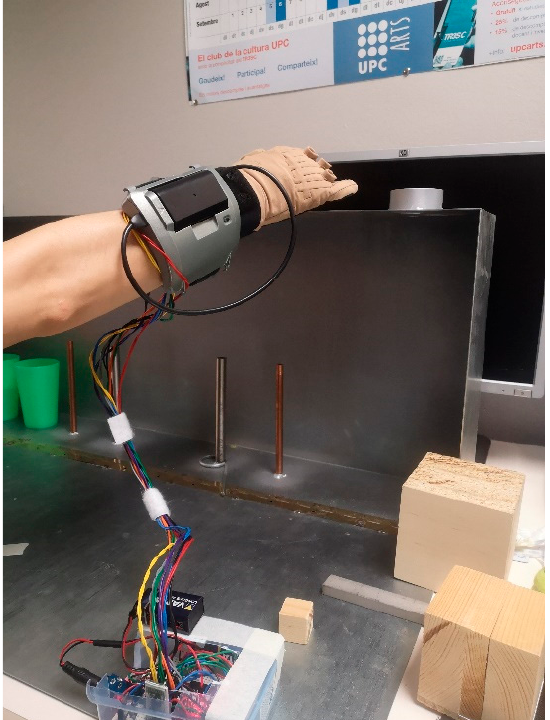
Figure 3. A participant is wearing the hand motion system, performing the Action Research Arm test (ARAT).